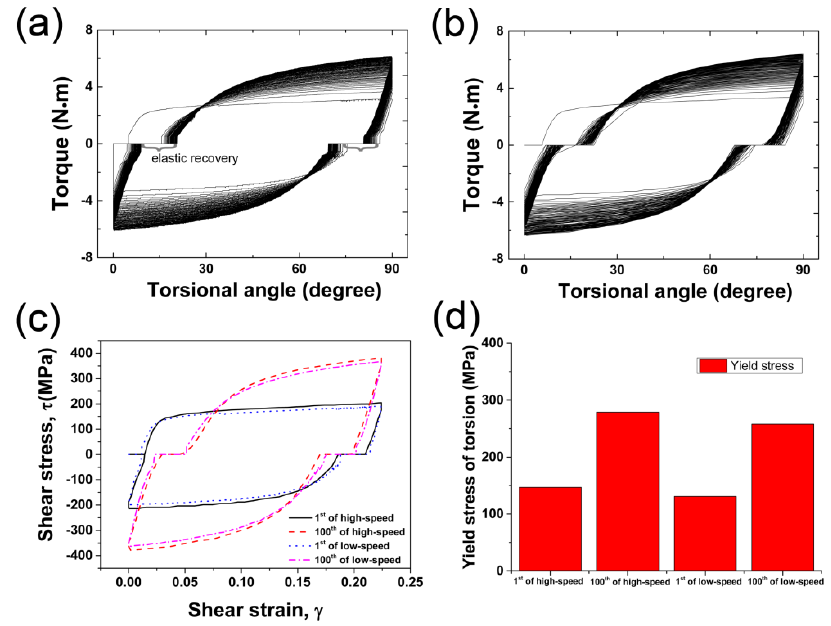
Figure 5. Microstructure before torsion ( a ), sample size of torsion processing ( b ), processing schematic ( c ), and locations of microstructure characterization ( d ).